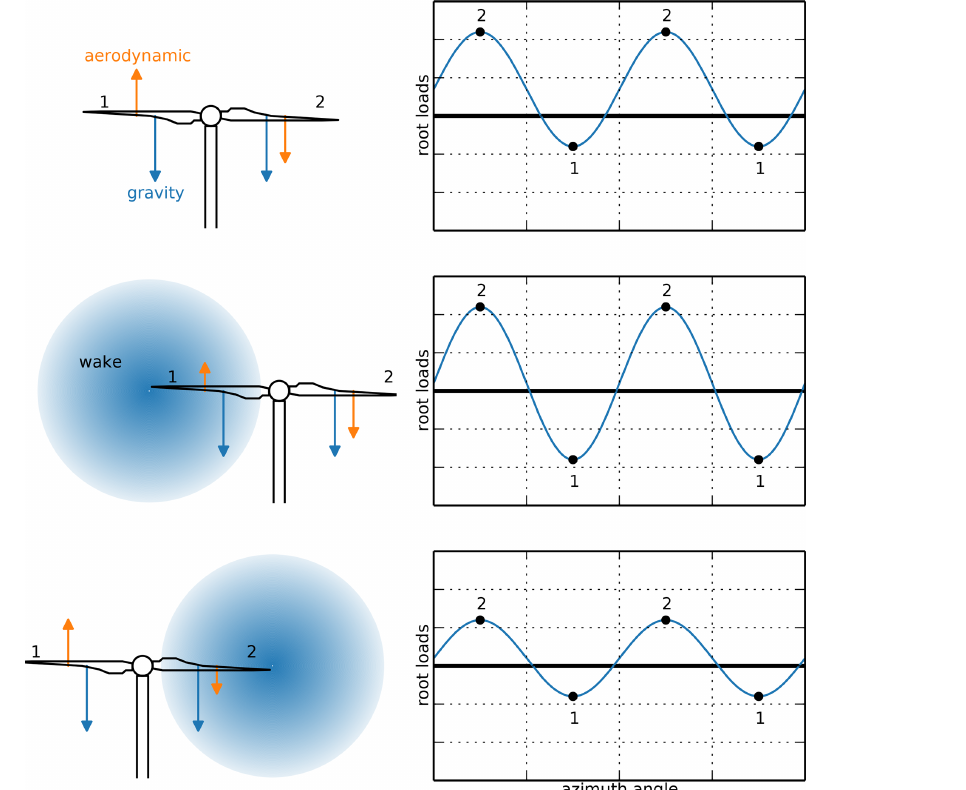
Figure 12. Exaggerated lead–lag load differences for different waking scenarios. Shown conditions are freestream, partially waked that increase load fluctuations, and partially waked that decrease load fluctuations. The different combinations of the gravitational force and the aerodynamic force along the blade cause different load fluctuations. Blade positions 1 and 2 are labeled on the turbine figures on the left, which correspond to the numbered points in the loading figures on the